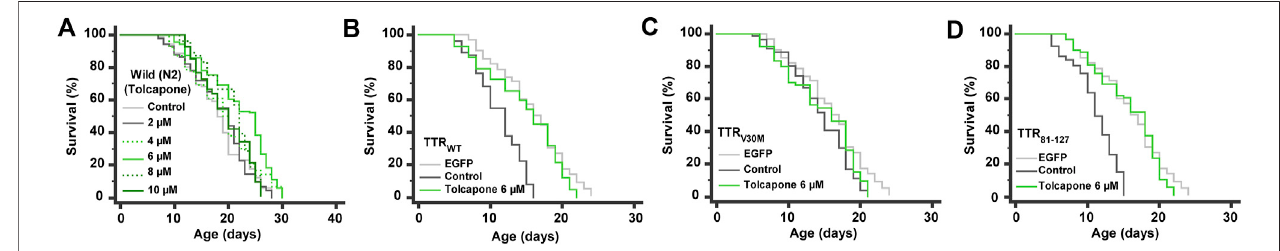
FIGURE5| Lifespananalyses.Lifepromotingabilityoftolcapone(positivecontrol) on (A) wild-type, (B) TTR WT , (C) TTR V30M ,and (D) TTR 81-127 worms. Combined data of three independent biological trials were presented. See Supplementary Table S3 for statistical details of lifespan analyses.